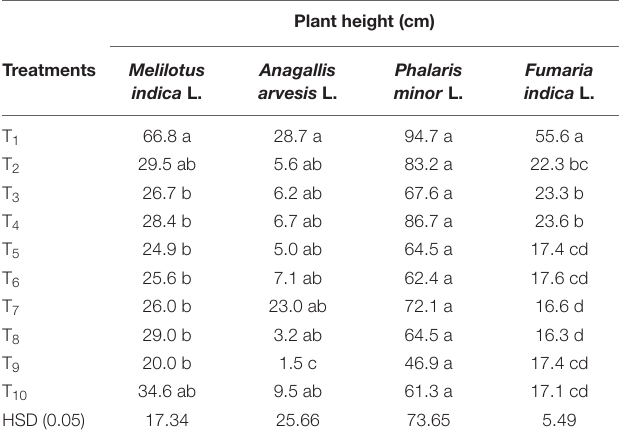
TABLE 5 | Influence of metribuzin alone and with adjuvants on plant height (cm) of weeds growing in wheat (average of 2 years’ data). Plant height (cm)